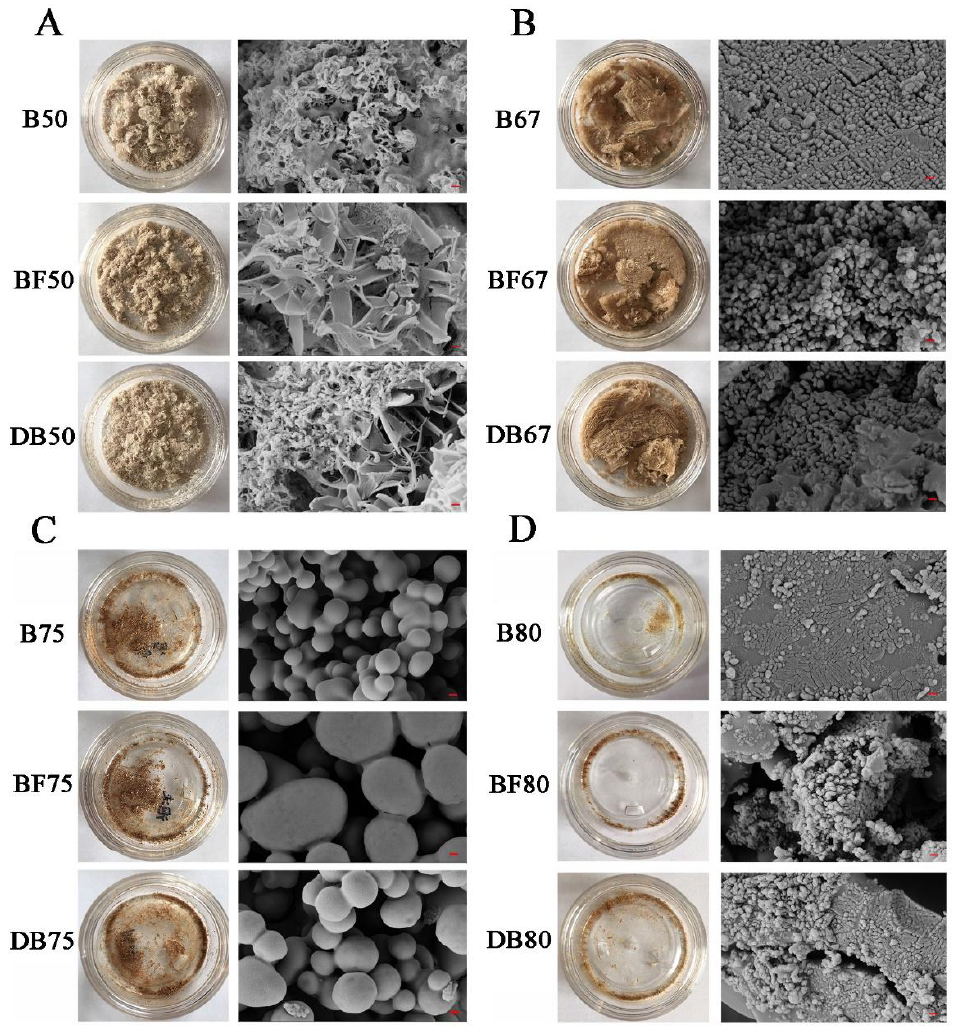
Figure 1. Photographs and SEM images of arabinoxylan. ( A ) referred to the photograph and SEM images of AX precipitated by 50% ethanol; ( B ) referred to the photograph and SEM images of AX precipitated by 67% ethanol; ( C ) referred to the photograph and SEM images of AX precipitated by 75% ethanol; ( D ) referred to the photograph and SEM images of AX precipitated by 80% ethanol. Zhou et al. performed some researches on the intracellular polysaccharides from Phellinus igniarius , which were precipitated by different concentrations of ethanol [21]. Similar structures of uniform spherical shape and large flakes were observed for polysaccharides precipitated from different